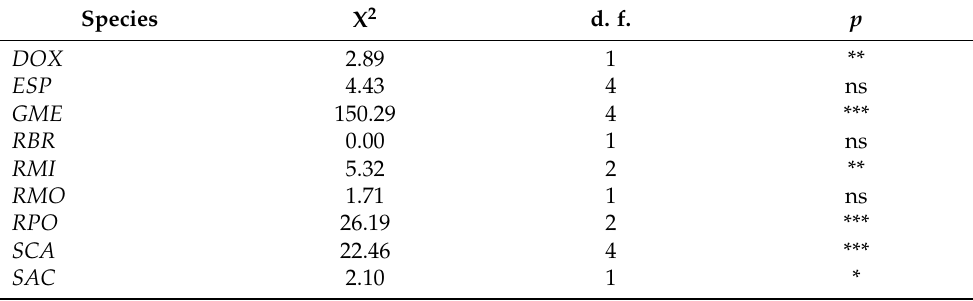
Table 4. Chi-square (X 2 ) values and related statistics (d.f.: degrees of freedom of the